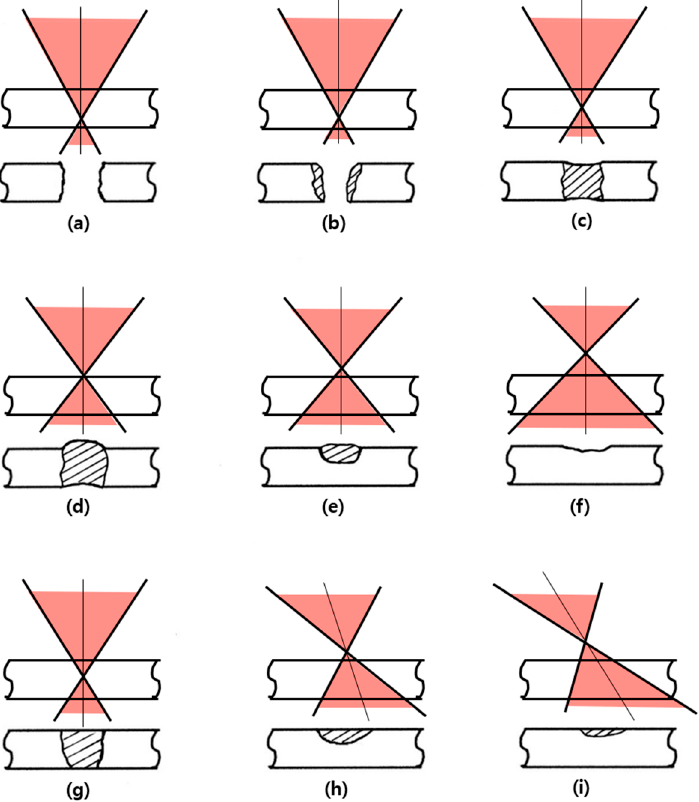
Figure 6. Effects of the beam focus position and beam angle on the focus depth and shape of laser drilling ( a – i ) (modified from Yeo’s illustrations) [53,74].